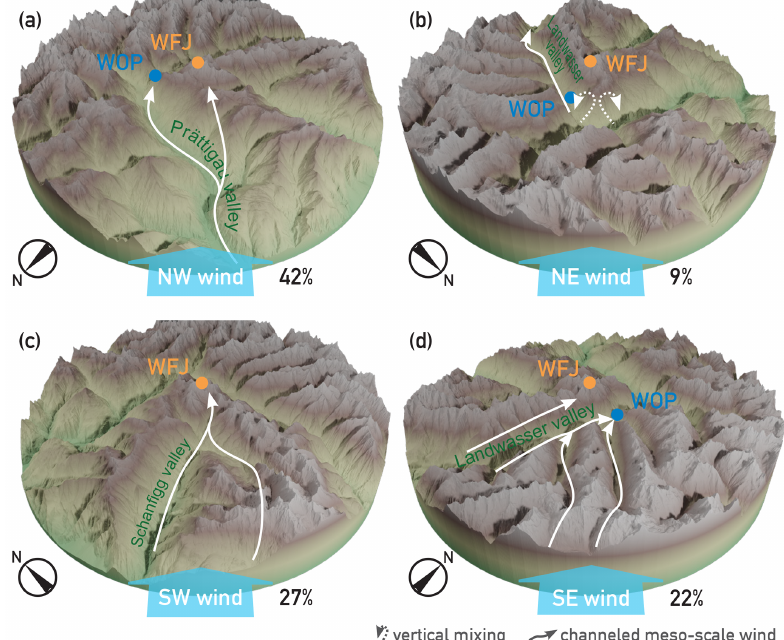
Figure 6. Channeled winds in the valleys (solid white arrows) of the mesoscale winds (light blue arrows) for the topography around the two measurement sites (WFJ – orange dot; WOP – blue dot) within a radius of 20km around WFJ for the four wind direction sectors (as defined in Fig. 1). The viewpoint in each panel is aligned with the mesoscale wind direction, is centered on WFJ (2693ma . s . l . ), and reaches down to an elevation of 500ma . s . l . The percentage of INP samples collected for each wind sector is indicated in the lower right of each subplot. In the NE wind case (b) , the potential vertical mixing (i.e., rising of air masses originating from the valley and mixing with the air masses aloft) due to the conditional instability of the narrow cross-valley air masses is shown (dashed white arrows). The elevation data were obtained from the digital height model DHM2 from the Federal Office of Topography,